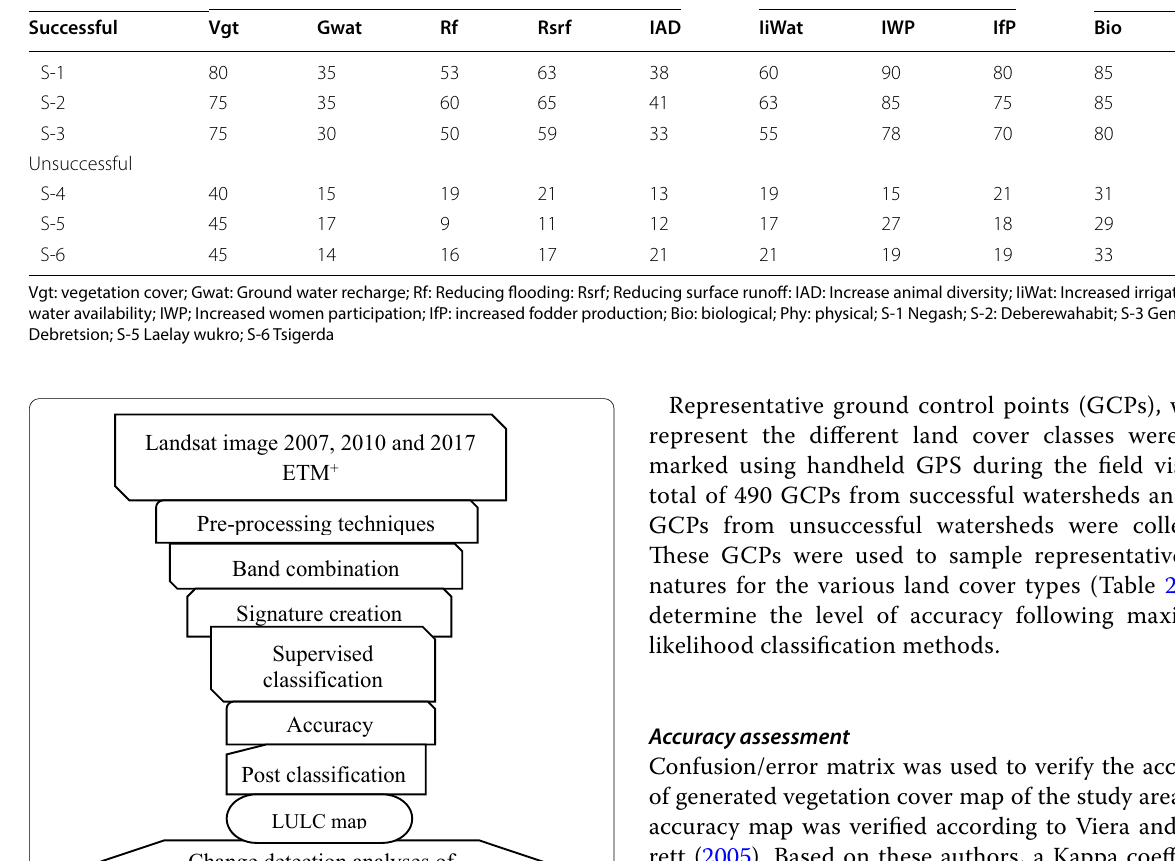
Table 1 Criteria used to evaluate the performance of integrated watershed management practices in Tigray, Ethiopia